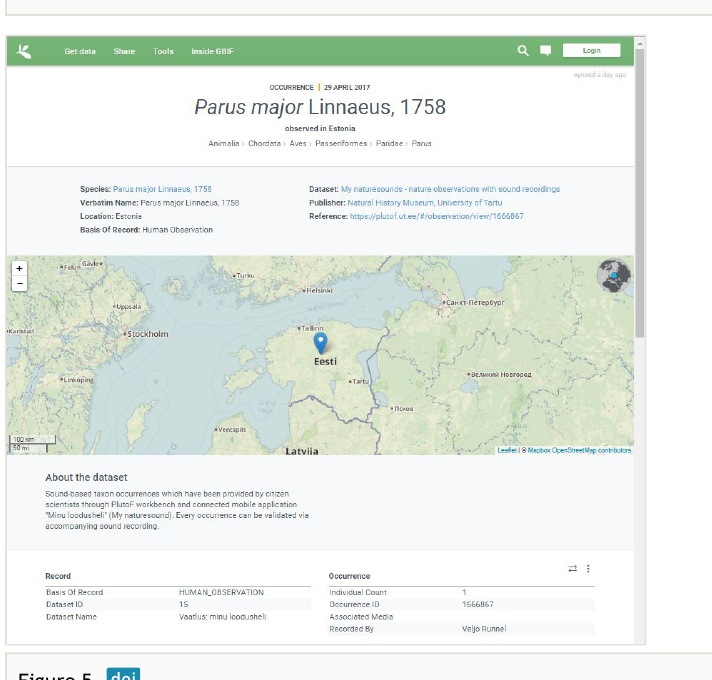
Figure 4. The properties of a multimedia fi le viewed on PlutoF workbench.